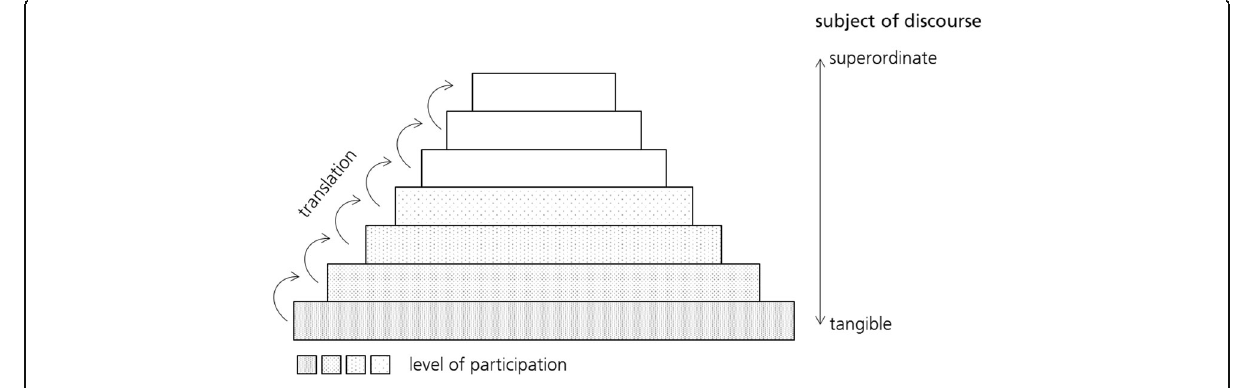
Fig. 7 Levels of participatory agenda setting © Fraunhofer